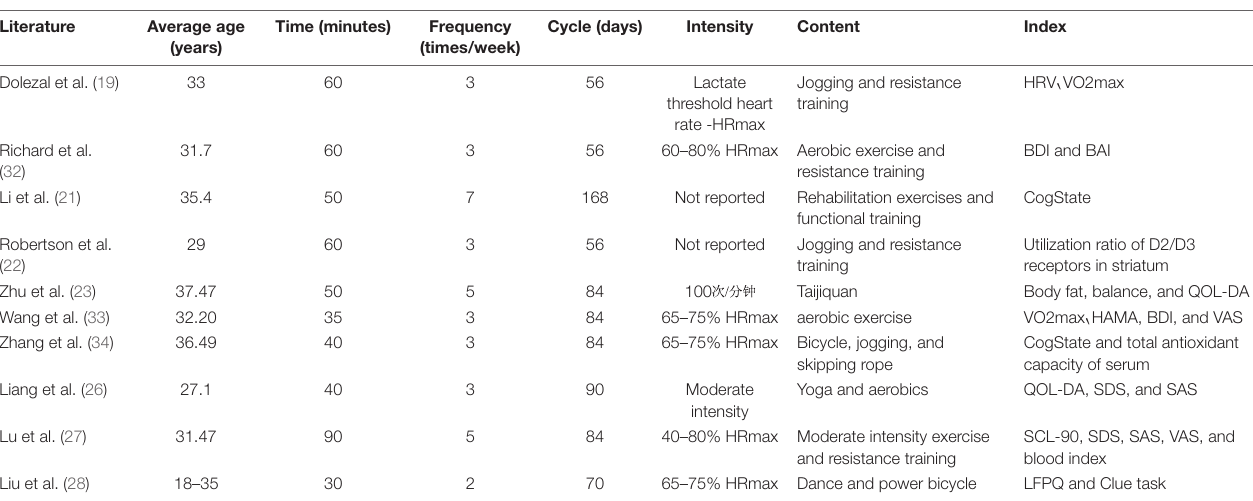
TABLE 3 | Information list of exercise intervention programs for people with amphetamine use disorder. Literature